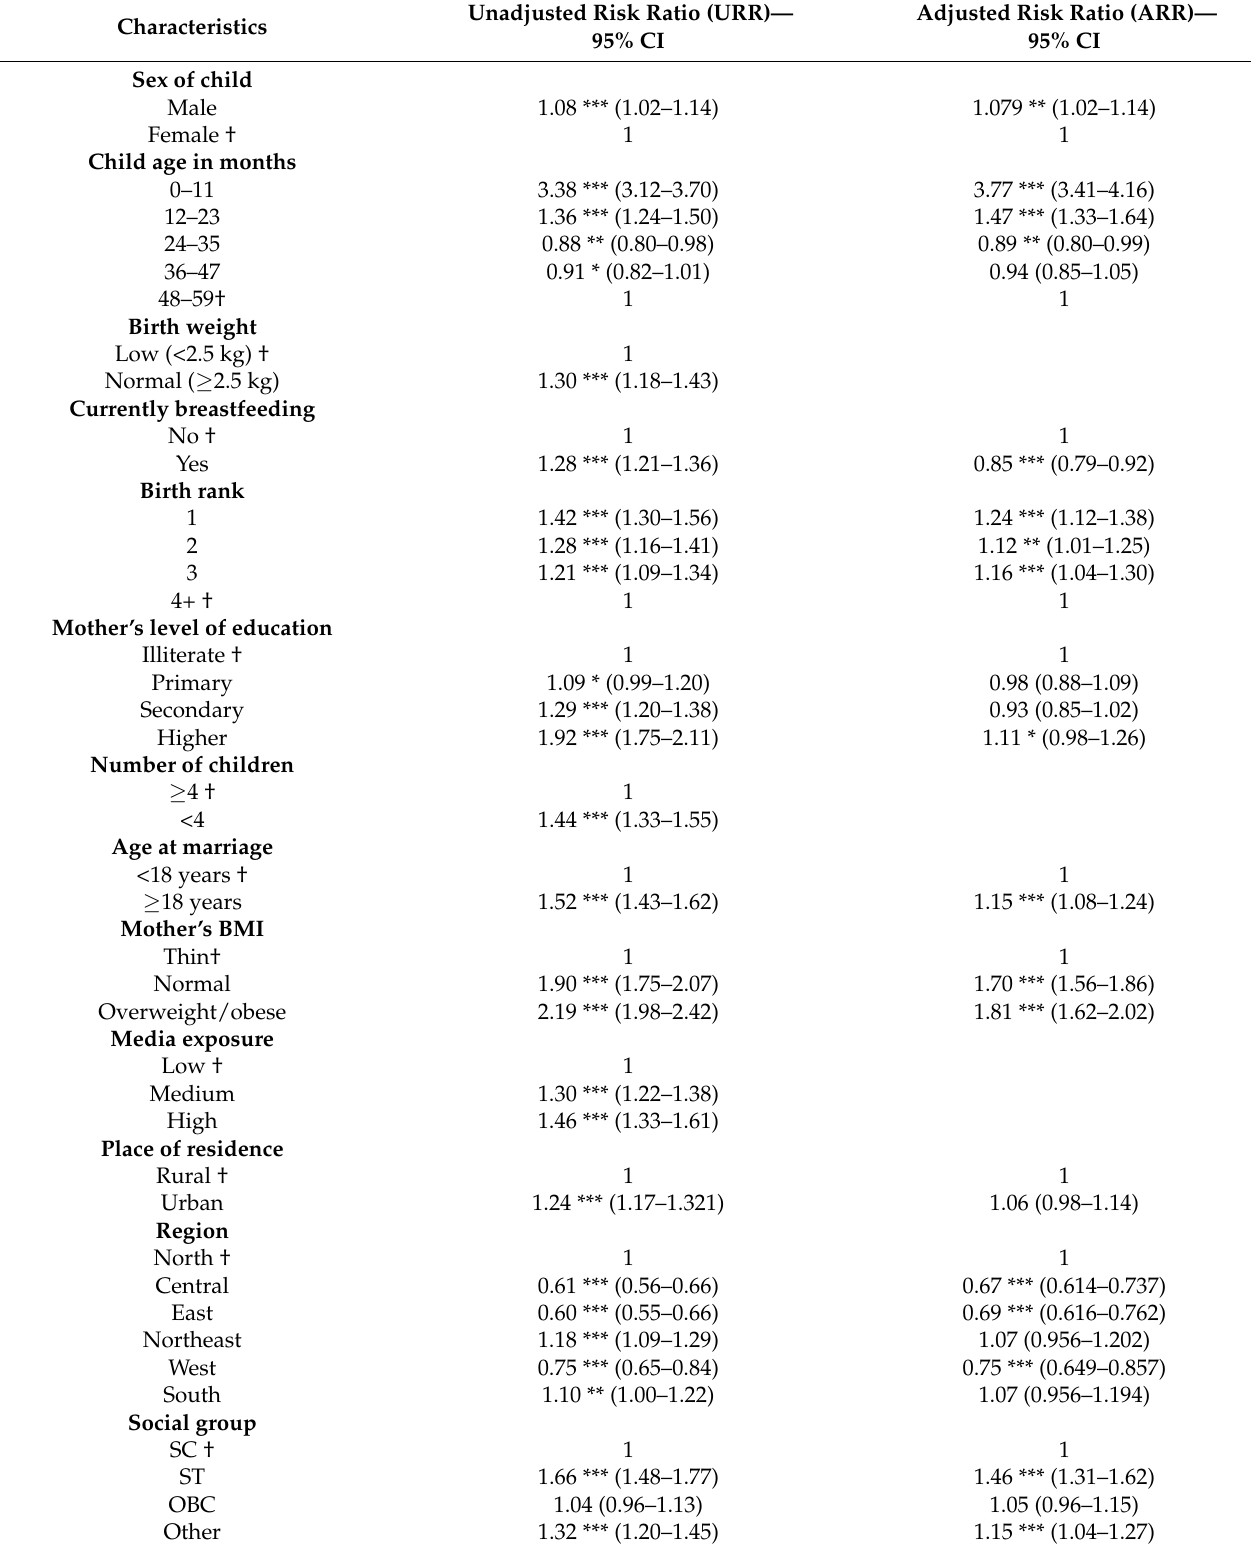
Table 5. Factors associated with childhood overweight/obesity in India, NFHS,